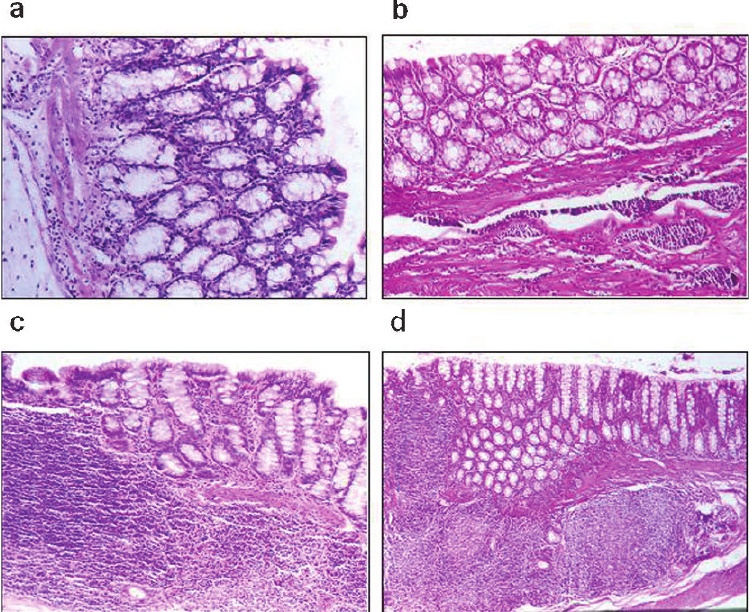
Figure 3 - (a) Histologic section of the colon of a group A1 animal (control) exhibiting an atrophic mucosa (H&E 6 400). (b) Atrophic colonic mucosa and slight MALT hyperplasia in a group 2 animal (prophylaxis) (H&E 6 200). (c) Atrophic colonic atrophy with MALT hyperplasia in a group B1 animal (control) (H&E 6 100). (d) Normal mucosal thickness with MALT hyperplasia in a group B2 animal (treatment) (H&E 6 40). MALT, mucous associated lymphoid